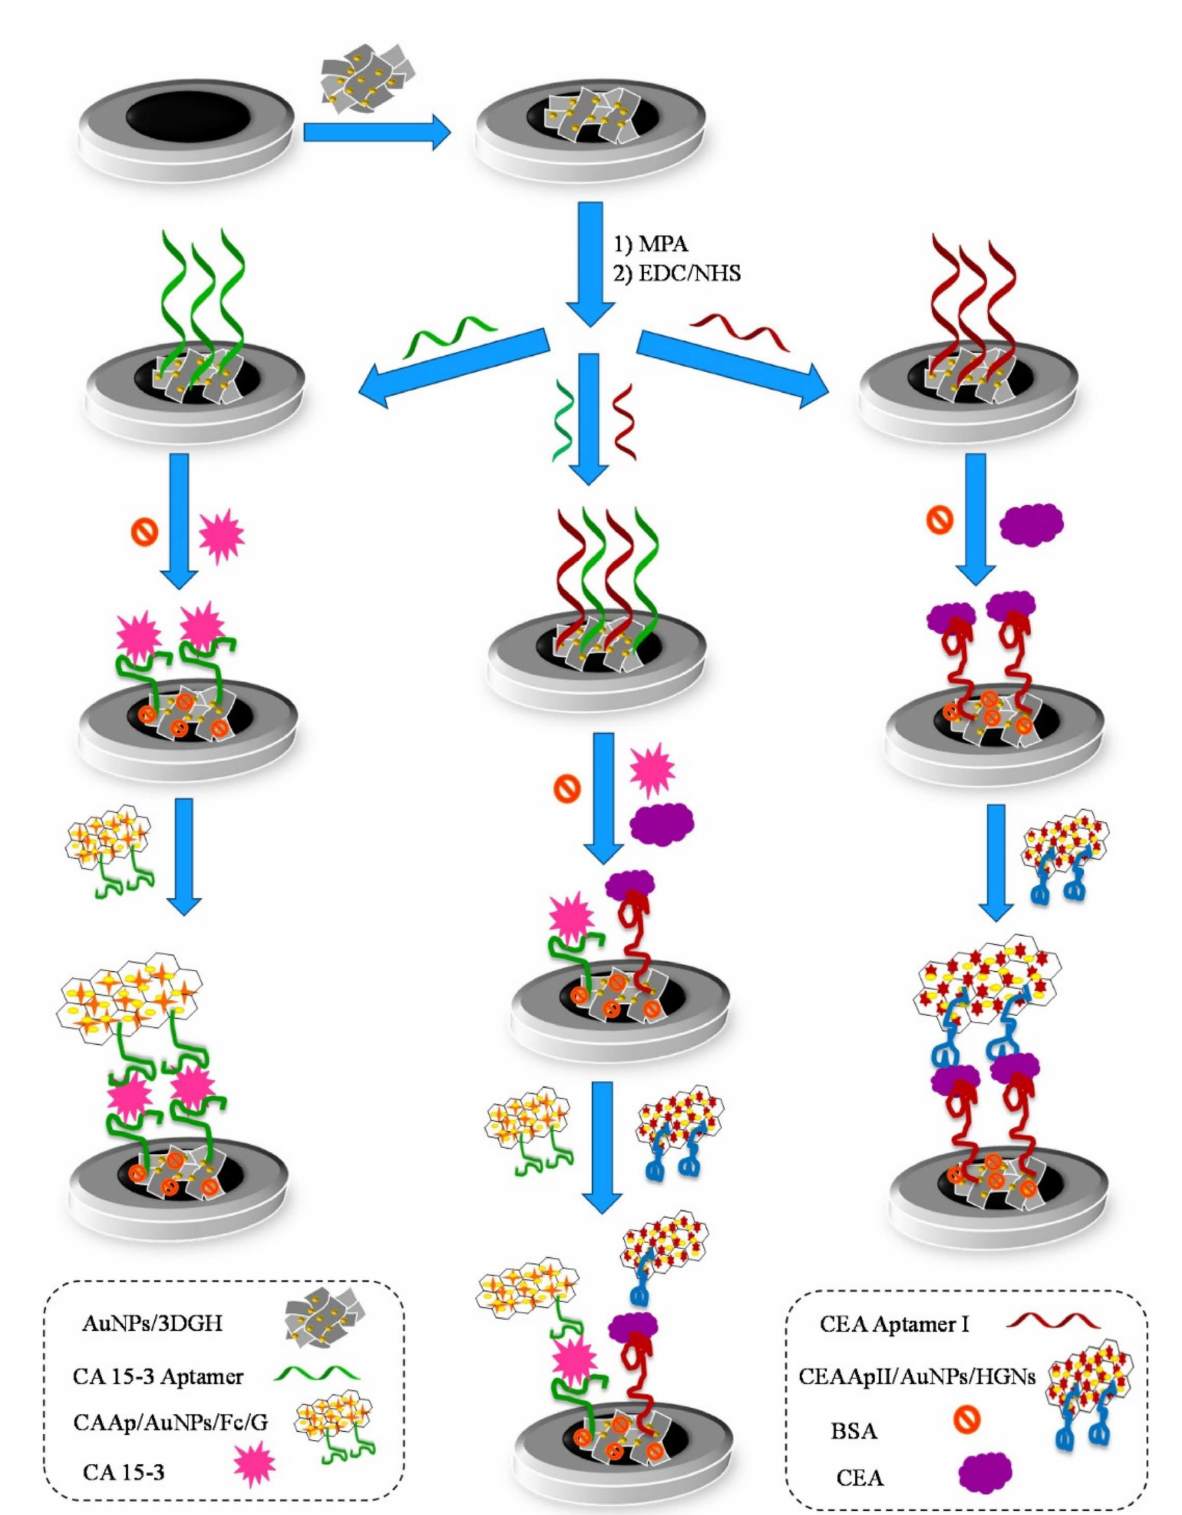
Figure 4. The scheme of the sandwich–type aptasensor preparation steps for the single and si- multaneous detection of CEA and CA 15–3 biomarkers (reprinted with permission from Shekari et al.